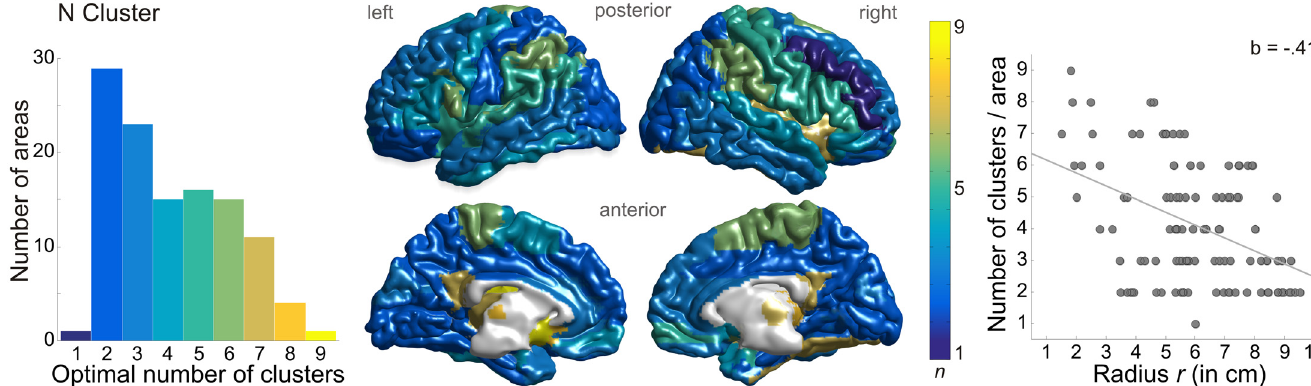
Fig 5. Distribution of number of clusters. (left) Histogram of cluster numbers across all 115 brain areas. Bin width is one. (middle) Topography of cluster numbers (colour-coded from 1, blue, to 9, yellow; bin width is one). (right) Linear regression reveals a dependency of number of clusters per area and the radius r from the centre of the brain. The number of clusters decreases with increasing radius. Data underlying this plot can be found in S2 Data.